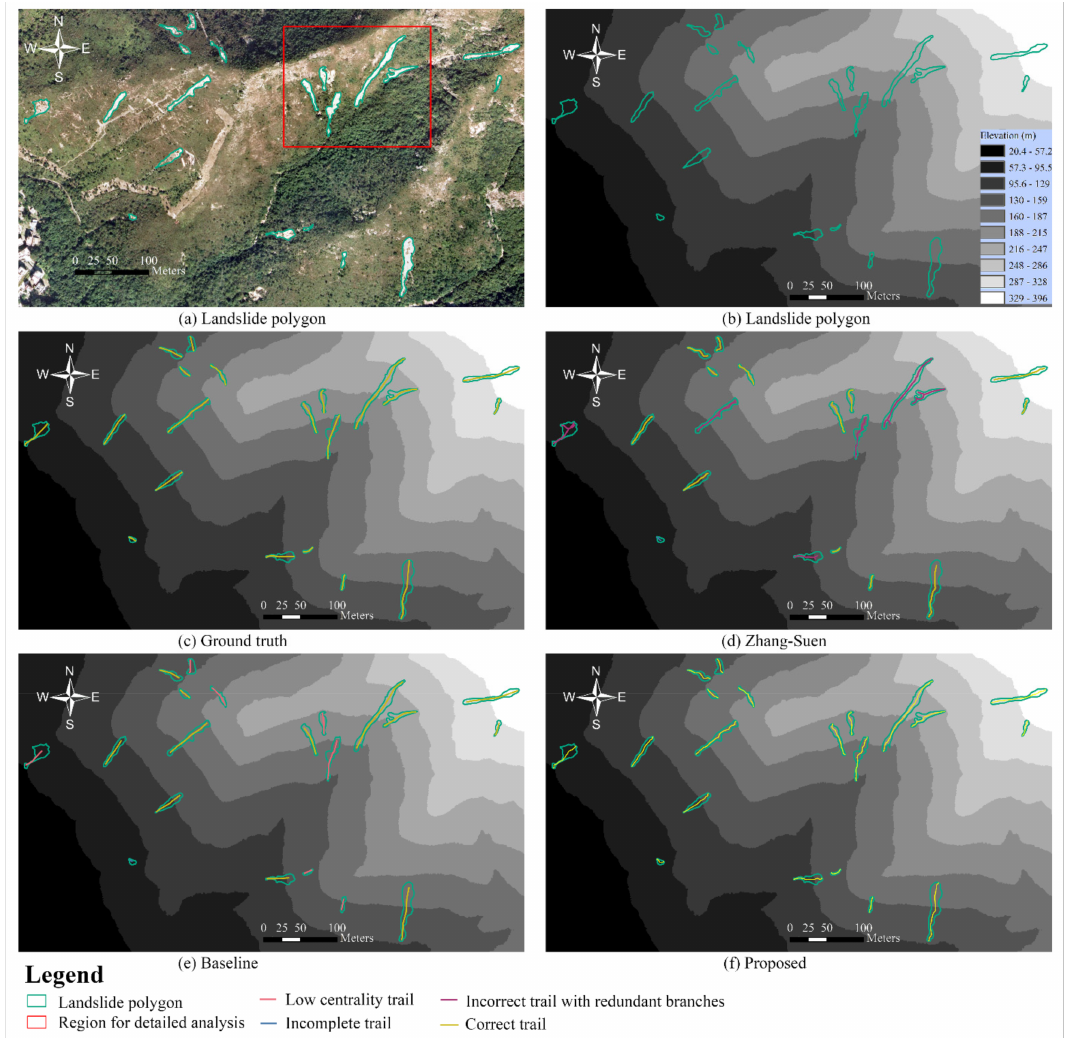
Figure 12. Landslide trail extraction results for the study area A. ( a ) Landslide polygon overlaid on aerial photo; ( b ) landslide polygon; ( c ) landslide trails ground truth; landslide trail result obtained by ( d ) Zhang-Suen’s method, ( e ) the baseline method, and ( f ) the proposed method. Landslide features in ( b – e ) are overlaid on DEM. The red box in ( a ) indicates a sub-region used for detailed